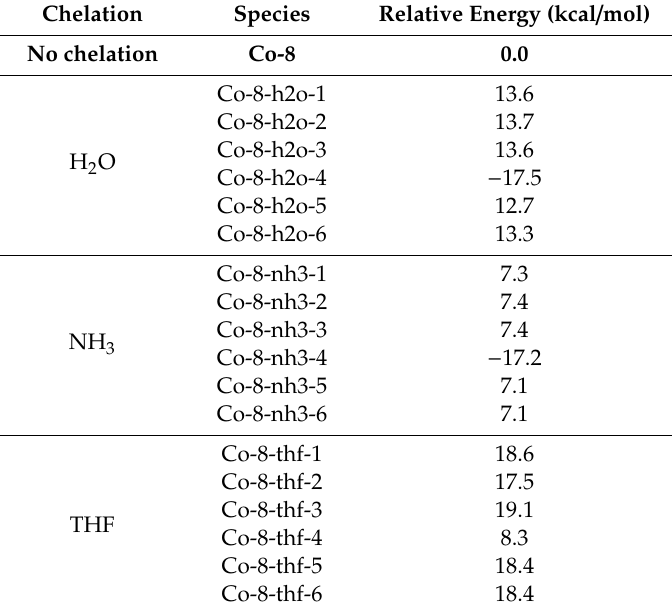
Table 2. The e ff ect of H 2 O, NH 3 and THF to the stabilization of complex I-8 ( t Bu-PNP-Co).